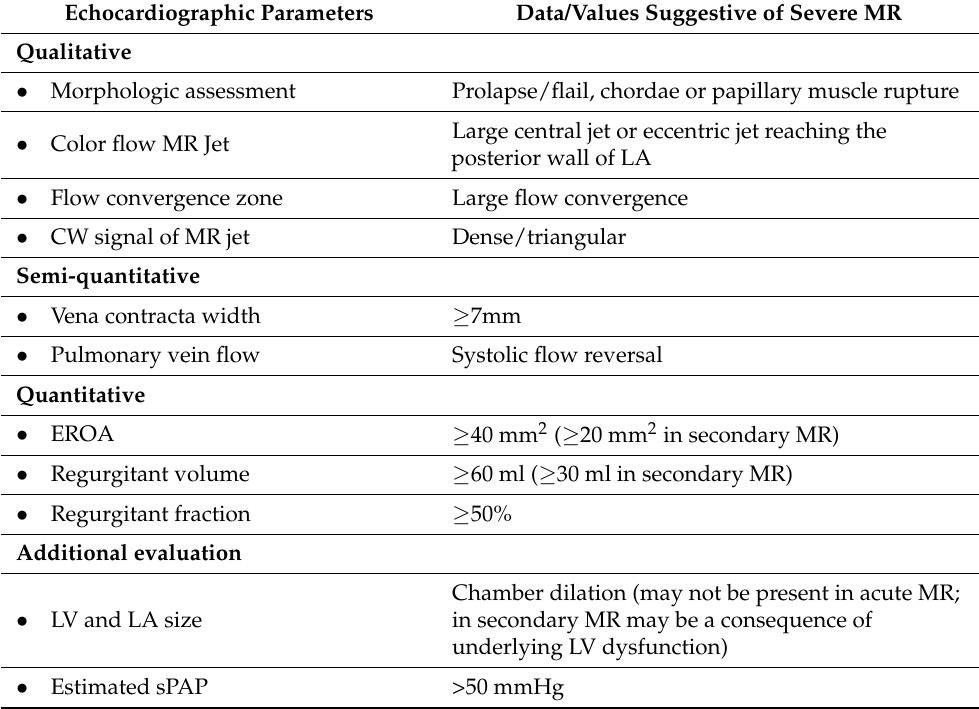
Table 2. Main echocardiographic findings suggesting severe